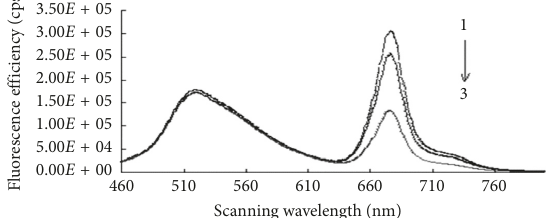
Figure 2: Fluorescence spectra of chlorophylls in green tea infusion at different β -CD concentrations ( β -CD concentrations: 1: 0.2%; 2: 0.05%; 3: 0%) concentration used in above experiments.